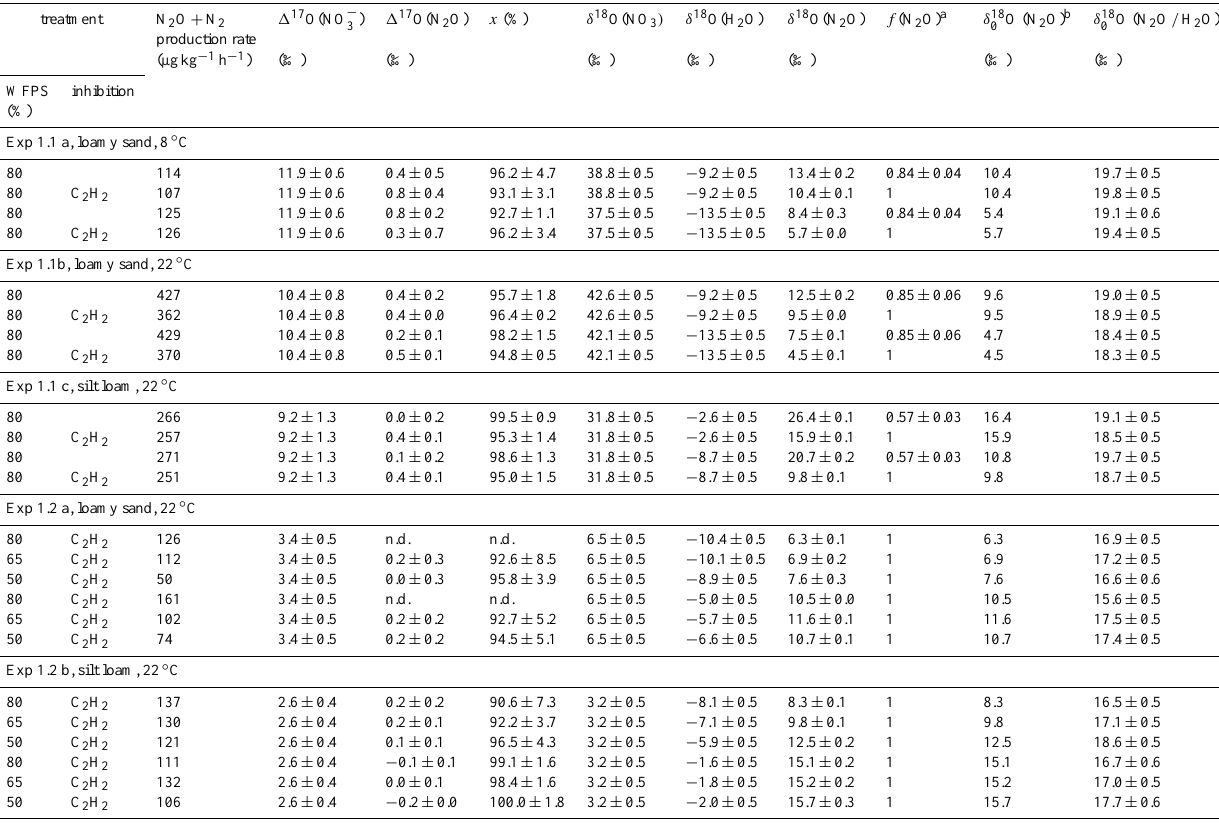
Table 1. Exp 1 results: soil moisture (expressed as water-filled pore space: WFPS), N 2 O + N 2 production rate (expressed as mass of N as sum of N 2 O and N 2 per mass of dry soil per time), 17 O excess in soil nitrate ( (cid:49) 17 O(NO 3 )) and in N 2 O ( (cid:49) 17 O(N 2 O)) with calculated ) , soil water (H 2 O) and N 2 O with calculated isotope exchange with soil water ( x ), and oxygen isotopic signature ( δ 18 O) of soil nitrate (NO − 3 ratio difference between soil water and N 2 O ( δ 18 O (N 2 O / H 2 O)). For samples with non-inhibited N 2 O reduction the N 2 O mole fraction 0 ( f (N 2 O)) was taken into account to calculate the δ 18 O unaffected by N 2 O reduction ( δ 18 O(N 2 O)) and the respective δ 18 O(N 2 O / H 2 O). 0 0 Only Chile saltpeter treatments are presented, for which the individual determination of x was possible. Part of the data from Exp